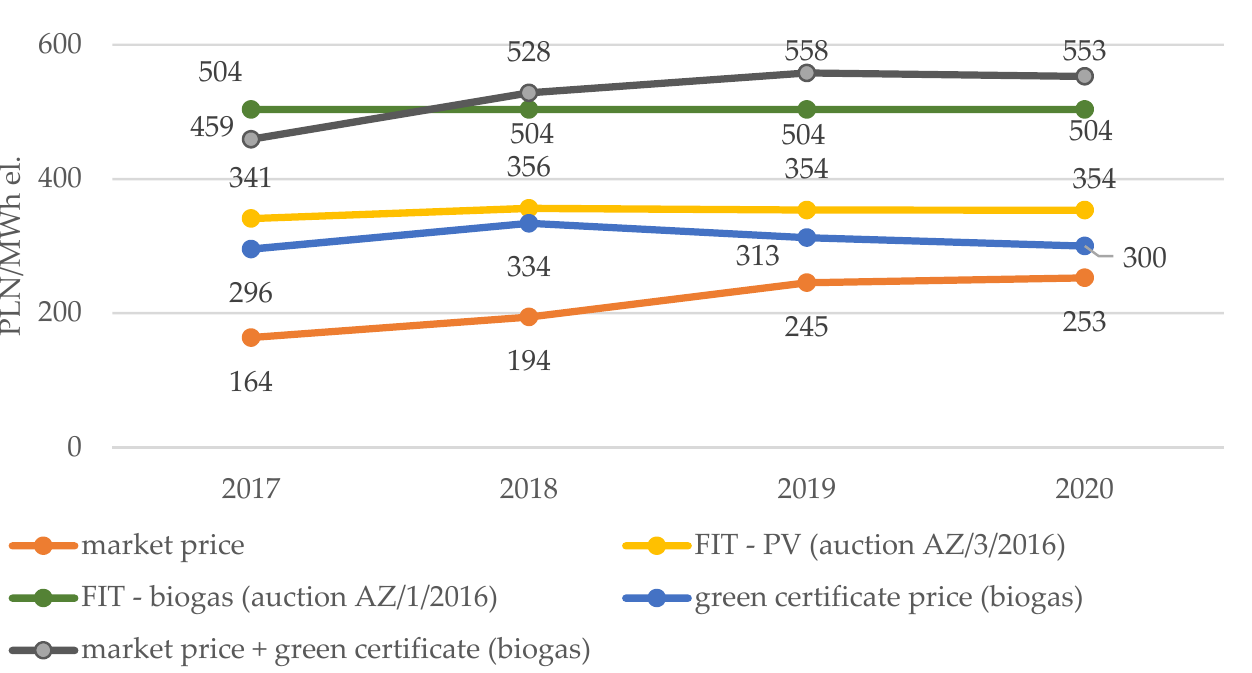
Figure 4. Electricity prices on the wholesale market and FIT for biogas and PV electricity in Poland [PLN/MWh]. Note: our elaboration based on data from [23]. 1 euro = ca. 4.7 PLN.